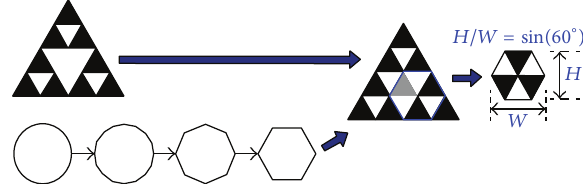
Figure 2: Generation of hive triangle pattern from circle and Sierpinski triangle.